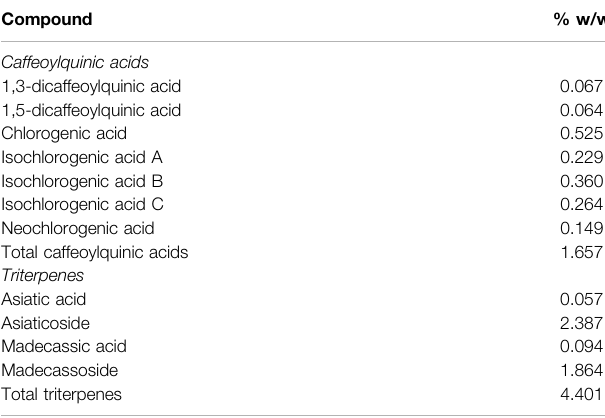
TABLE 1 | HPLC-HRMS/MS quanti fi cation of phytochemicals in a representative batch of Centella asiatica water extract (CAW). Compound %